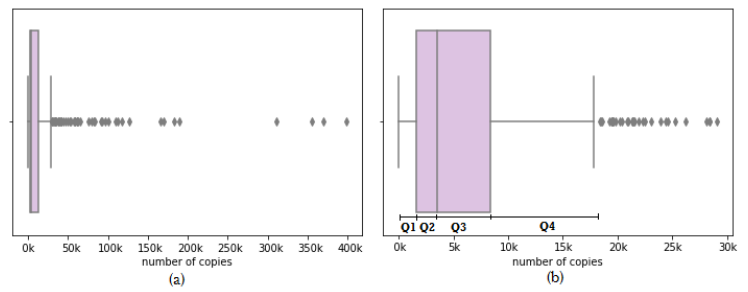
Figure 3. Results of quartiles segmentation. The boxplot represents the mean (center lines), standard deviation (box), range (dotted lines), and outliers (crosses) of the number of copies of books. ( a ) The quartiles can hardly be appreciated given the number of existing outliers. They are eliminated above